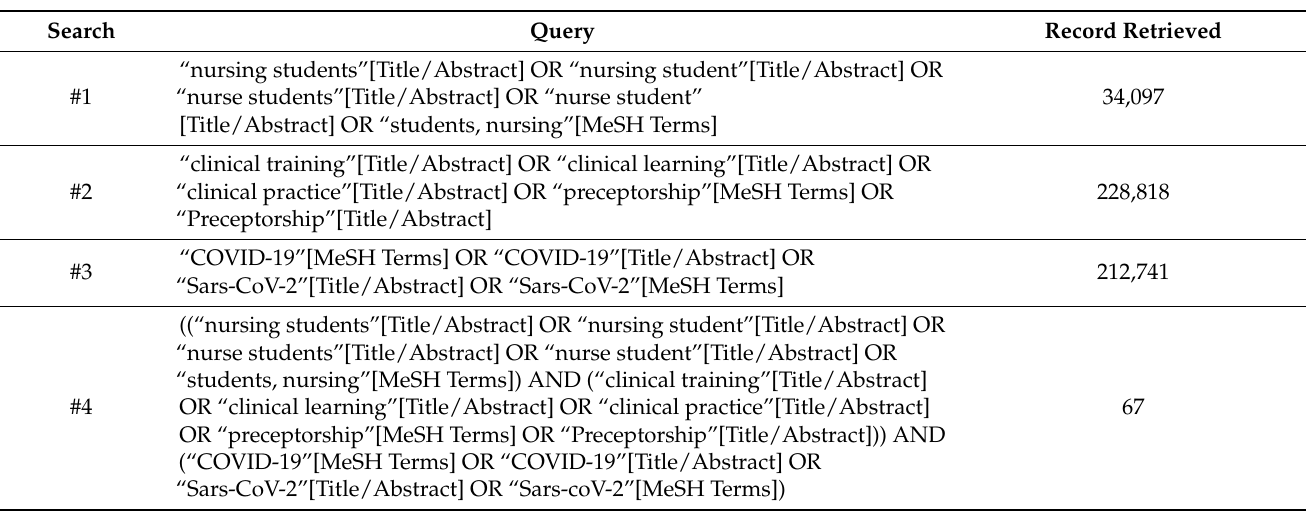
Table 1. Search strategy for MEDLINE (via